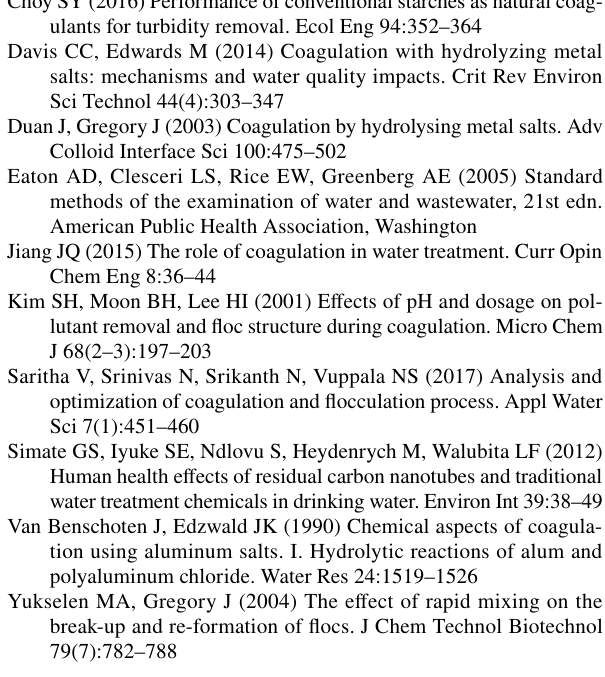
Fig. 8 Resultant pH at varying doses of coagulants (pH 6)